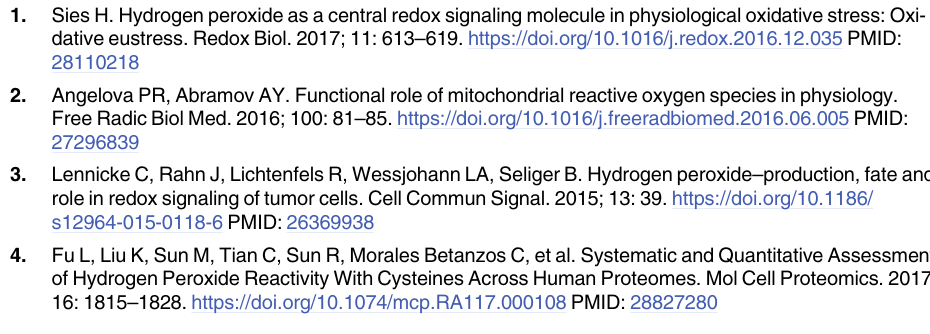
S9 Fig. Full Western blot image from Fig 5 stained for Prx3, visualized using IRDye800, show- ing samples from 30 min of generation, 0–25 mM D-ala (left to right). (TIF) S10 Fig. Corresponding stain-free total protein image of 30 min Western blot. (TIF) S11 Fig. Full Western blot image from Fig 5 stained for Prx2 and Hsp60, visualized using IRDye680, showing samples from 1 hr of generation, 0–25 mM D-ala (left to right). (TIF) S12 Fig. Full Western blot image from Fig 5 stained for Prx3, visualized using IRDye800, showing samples from 1 hr of generation, 0–25 mM D-ala (left to right). S13 Fig. Corresponding stain-free total protein image of 1 hr Western blot. S14 Fig. Comparison of simulations from Fig 6 with experimental data from Fig